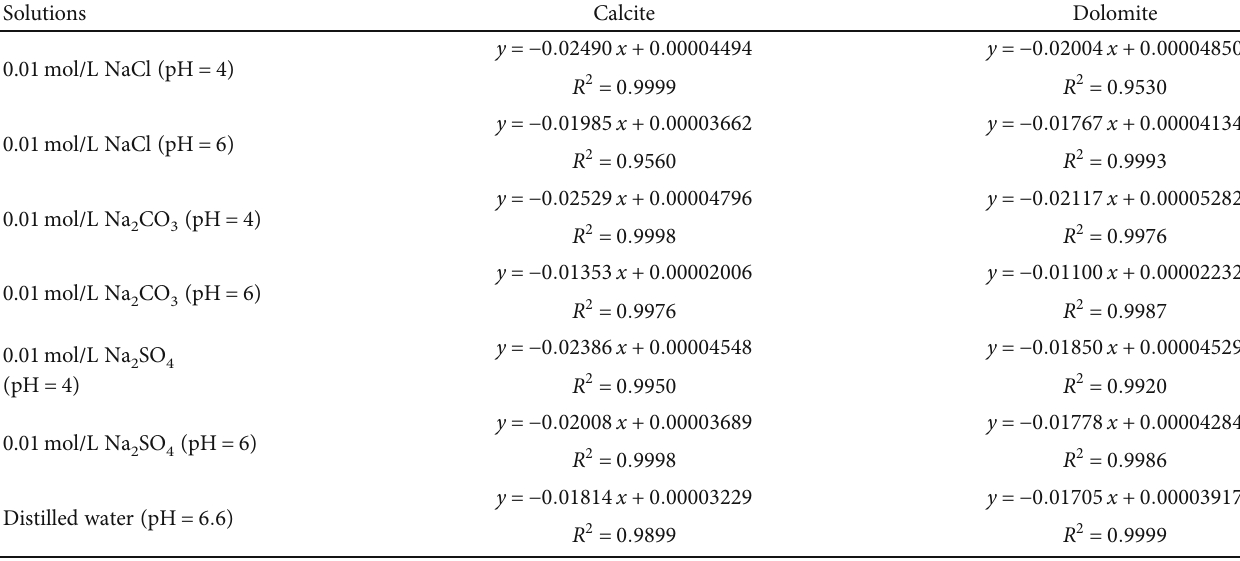
Table 8: Noyes-Whitney equations and correlation coe ffi cients of calcite and dolomite in fl owing solutions. Solutions